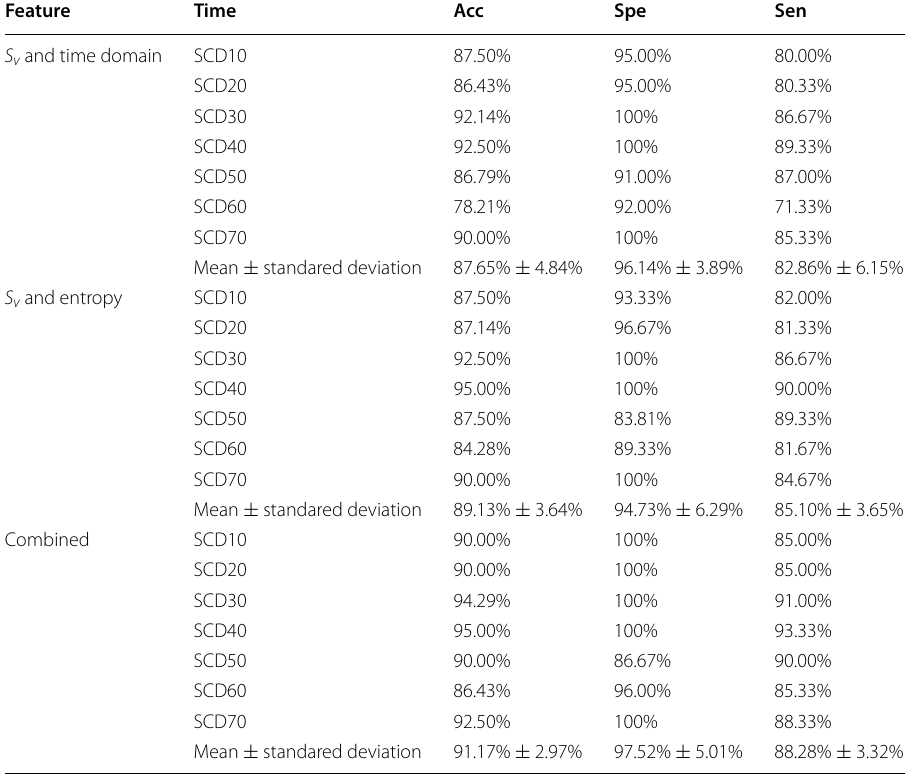
Table 4 Prediction accuracy with different feature combinations Feature